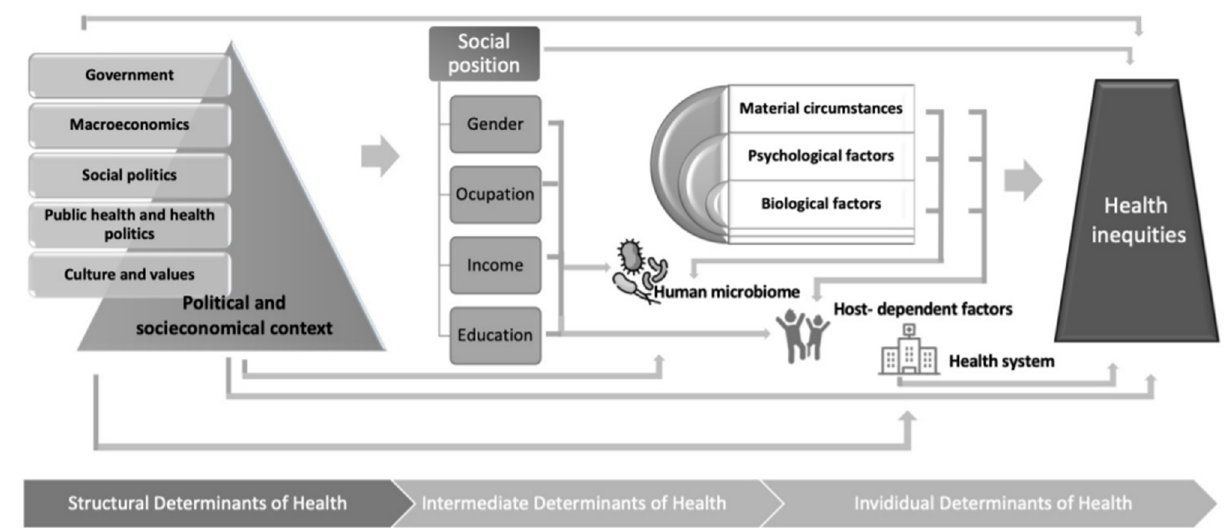
Figure 1. Human microbiome at the crossroad between social determinants of health and personalized medicine.